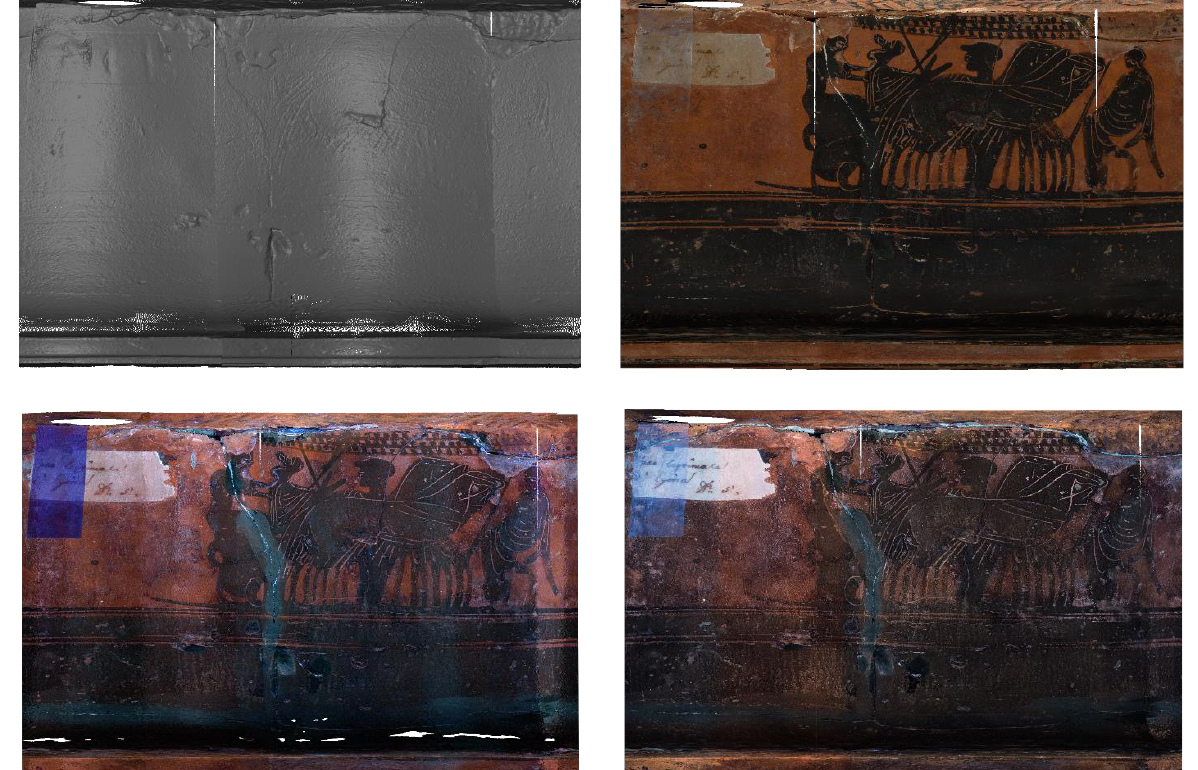
Figure 6. Rollout from the mesh model showing the geometry (a) and the three different texture mapping: VIS (b), UVL @ 254 nm (c), UVL @ 366 nm (d).